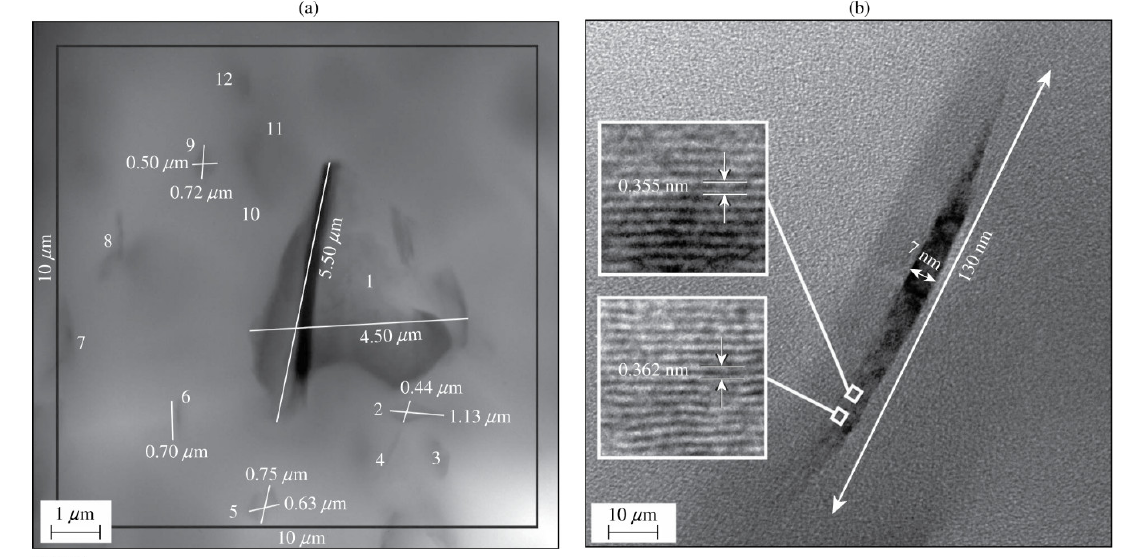
Figure 2. ( a ) Low-resolution (10 × 10-µm 2 area), representative TEM image of 1-wt% graphene PET-DLA 4060 nanocomposite. Twelve (most visible in the view) flakes are identified and the sizes of several flakes are listed. ( b ) HRTEM of the 7-nm × 130-nm nanoflake. Insets show images of graphene planes and interplanar distances from two different sections of the nanoflake (marked as squares).